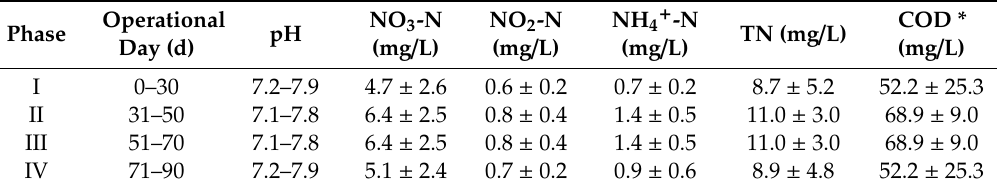
Table 1. Water quality of the WWTP e ffl uent used as